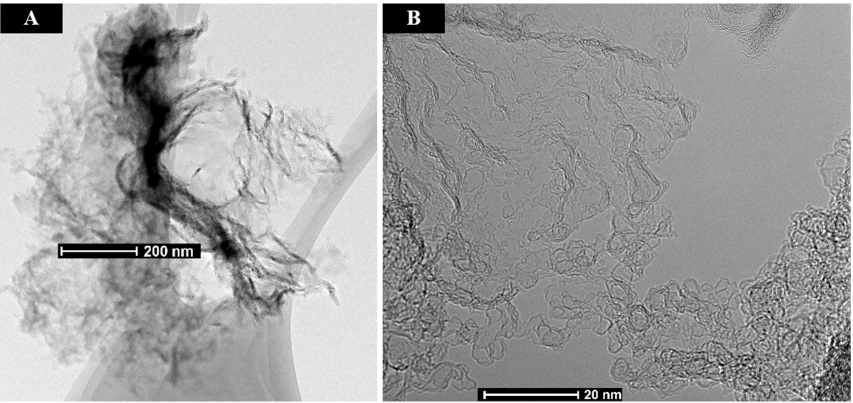
Figure A5. TEM images of anthracene coke—200 mJ/cm 2 . Figure A5. ( A , B ) TEM images of anthracene coke—200 mJ/cm 2